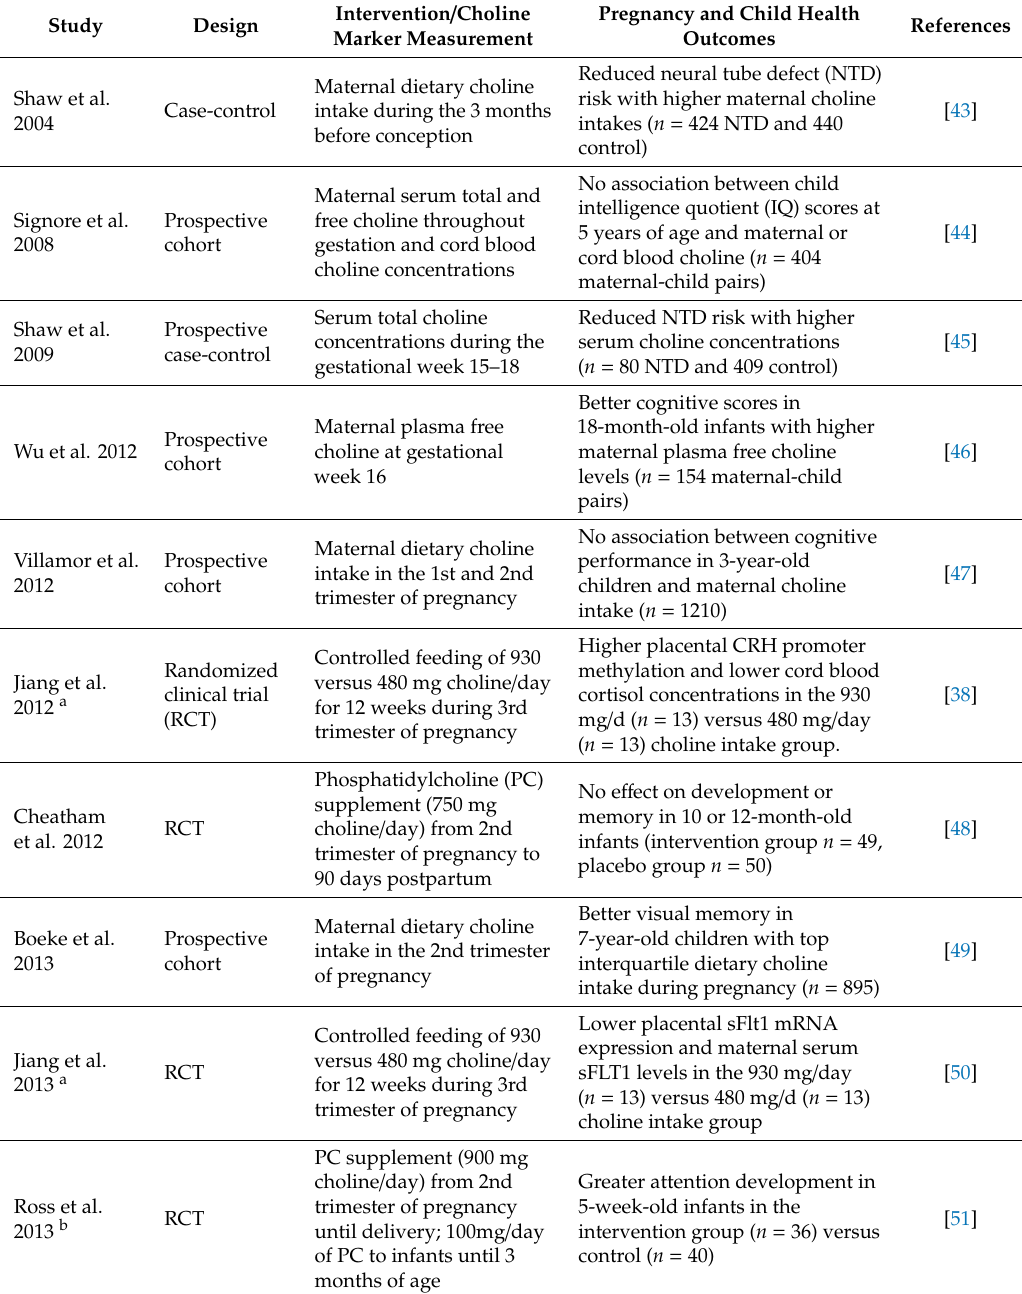
Table 1. Human studies with a focus on maternal choline intake (or status) and pregnancy and child health outcomes (in chronological